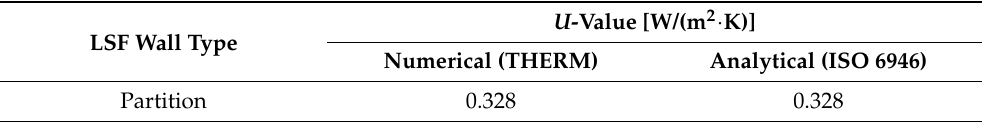
Table 3. Thermal transmittance computed for the simplified LSF walls assuming homogeneous